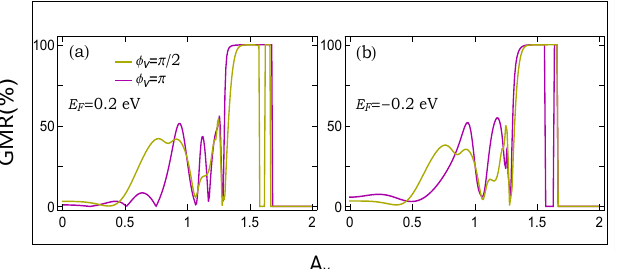
Figure 5. ( a , b ) (Color Online). Dependence of GMR with A x at two typical Fermi energies. The results are shown for two different AAH phases.